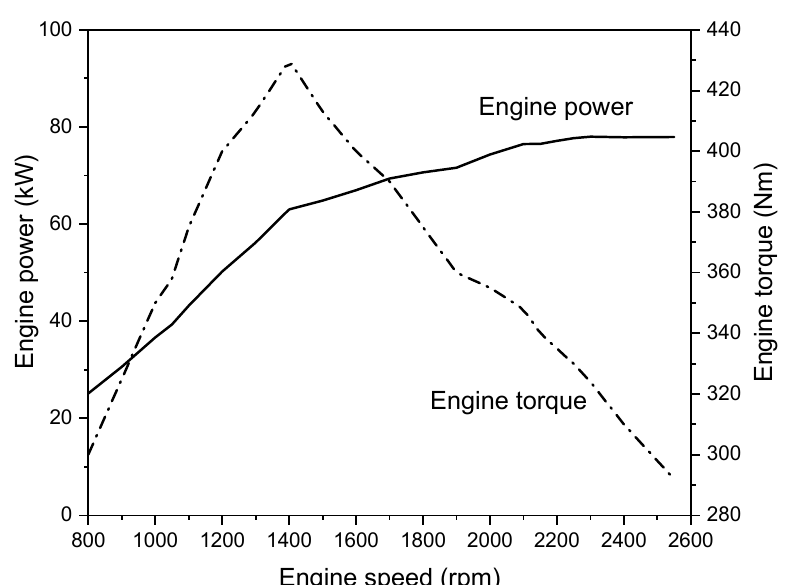
Figure 1. Engine performance map of the tractor used in this study.